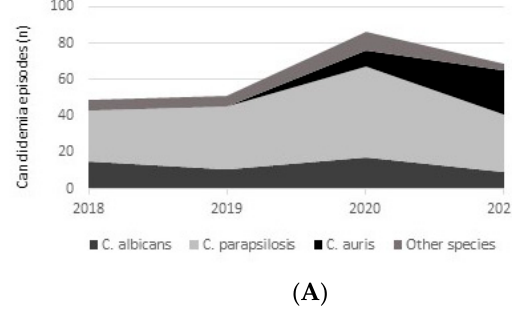
Figure 1. Distribution of Candida species responsible for candidemia over time, both in the overall ICU population ( A ) and among included patients ( B ).